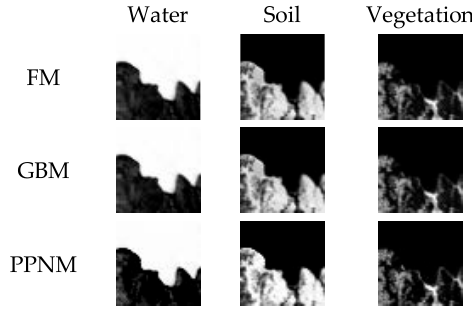
Figure 15. Abundance maps of AVIRIS data estimated by BCNMF.